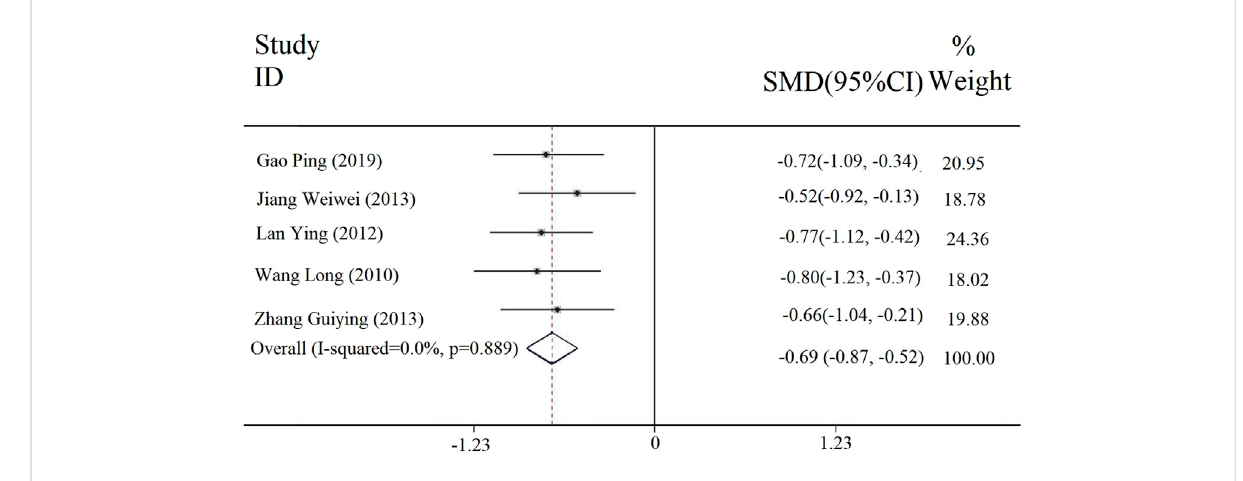
FIGURE 5 Forest plot of duration of the headache.